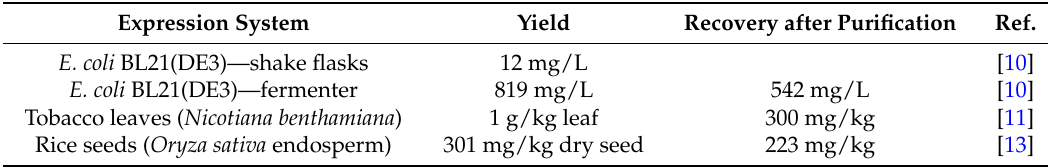
Table 1. Recombinant expression of